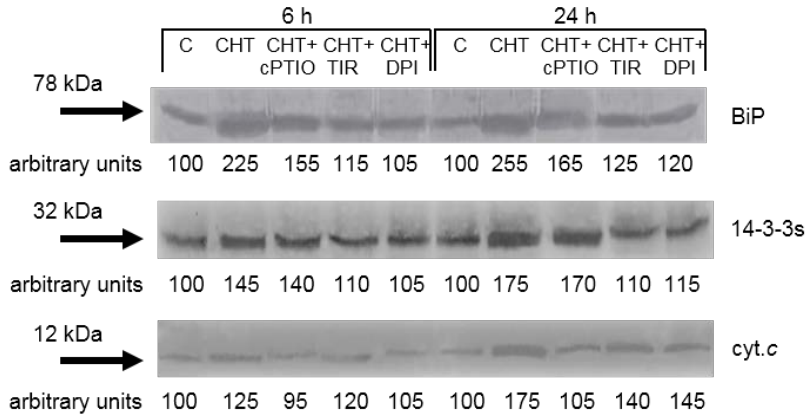
Figure 6. Effect of cPTIO, Tiron and DPI on the CHT-induced release of cytochrome c (cyc. c ) from mitochondria and increase in the levels of cytosolic 14-3-3 proteins and BiP. C: Control cells; CHT: Cells treated with 0.005% CHT; CHT + Cptio: Cells treated with 50 μM cPTIO + 0.005% CHT; CHT + TIR: Cells treated with 2 μM Tiron + 0.005% CHT; CHT + DPI: Cells treated with 10 μM DPI + 0.005% CHT. The results of a